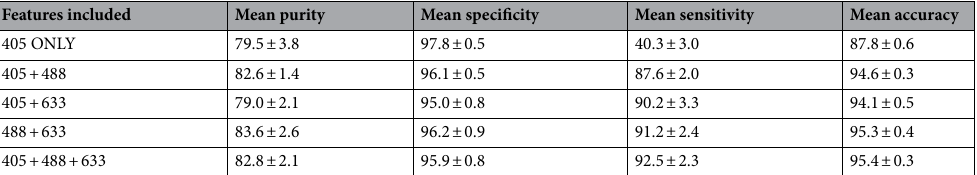
Table 3. Feature vectors examined along with average performance (± standard deviation). All models were trained and tested based on the described pseudocode (see Supplementary Fig. S1) with a fixed EBT model and zero-mean normalization method. The only variation introduced was the features used to develop the model.